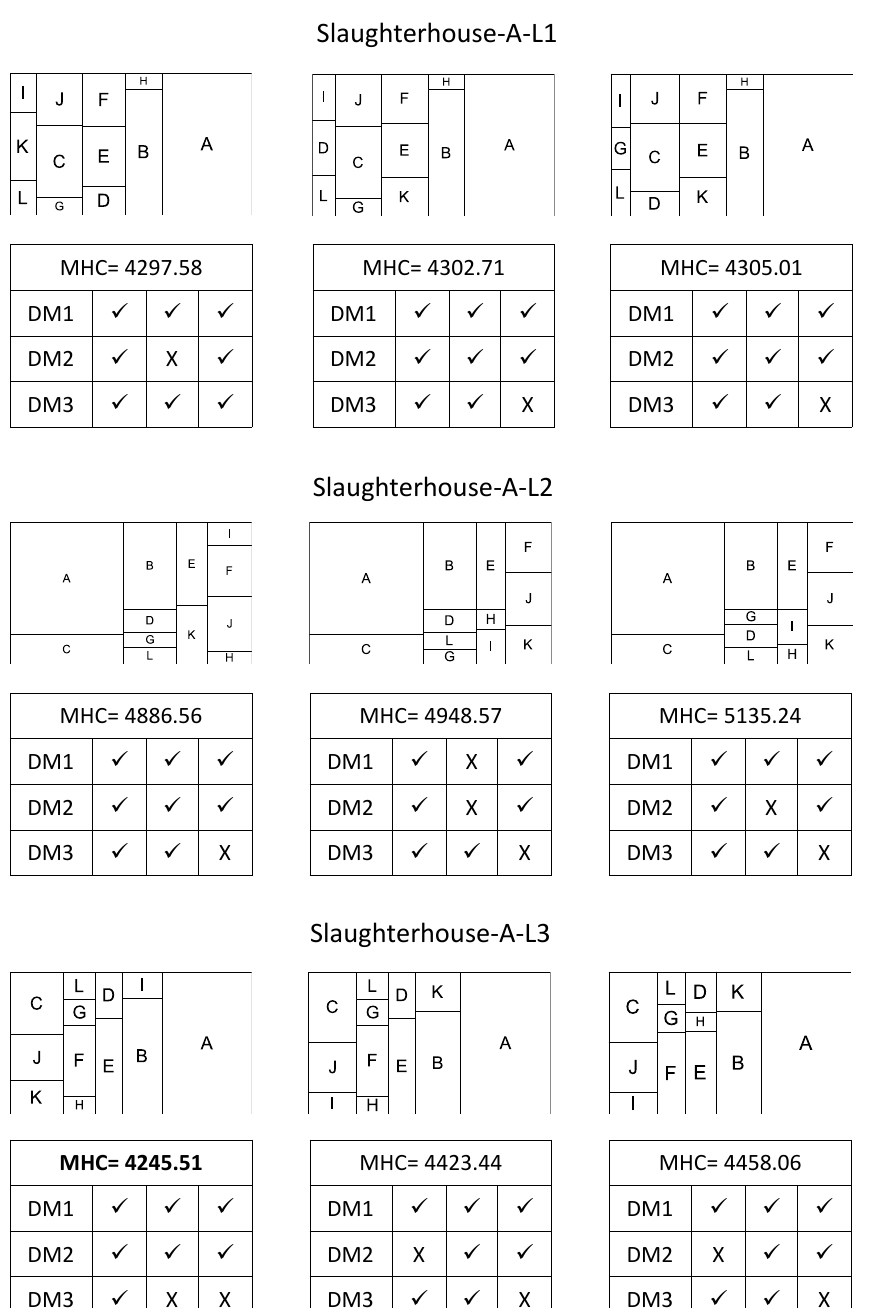
Figure 7. Best solutions found in Alternative launch 1 to 3 of Slaughterhouse